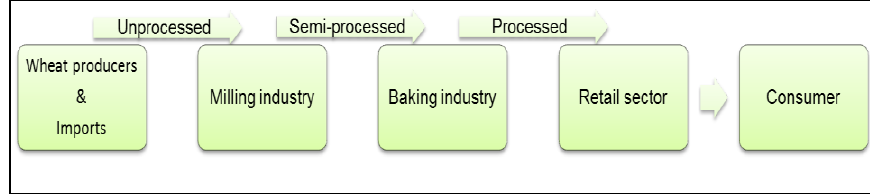
FIGURE 1: Structure of the South African wheat industry Source: Authors’ own